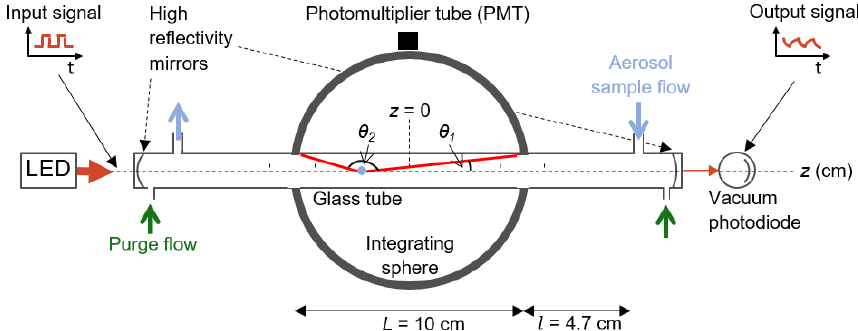
Figure 1. Schematic diagram of the CAPS PMssa monitor with relevant components and variables highlighted. A glass tube encapsulates the aerosol sample to be measured. A light-emitting diode (LED) delivers a square-wave modulated light signal as input to the optical cavity. The phase shift of the output signal from the cavity relative to the input signal is measured by a vacuum photodiode: this is the extinction channel of the instrument. Light scattered from the aerosol sample is collected by the integrating sphere and measured with a photomultiplier tube (PMT): this is the scattering channel of the instrument. θ 1 and θ 2 are the two truncation angles for light scattered from a particle at position z along the instrument axis (without considering reflection from the glass tube).